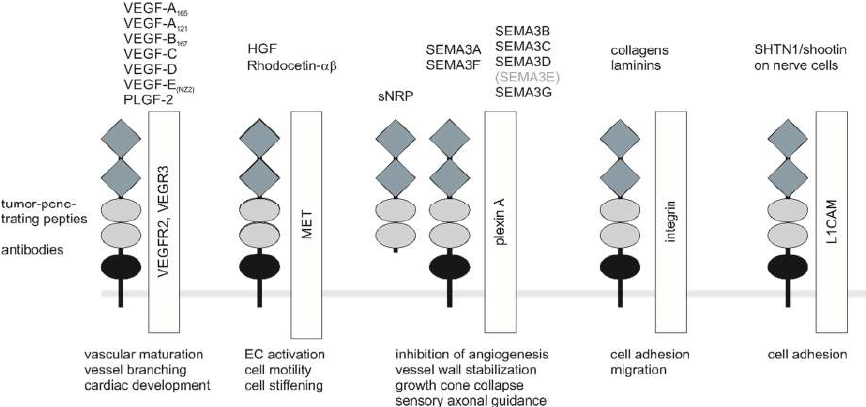
Figure 2. NRP coreceptors, ligands, and NRP-targeting compounds. For clarity, only monomers of receptors and coreceptors are shown. For signaling, dimerized ligands bind to a NRP dimer that interacts with a pair of receptor type kinases or plexin receptors. Soluble sNRP isoforms can interfere with the signaling of NRP-containing holoreceptors. Physiological NRP ligands involved in angiogenesis and tumor angiogenesis, vascular branching and maturation, as well as cardiovascular development, are VEGF-A 165 , VEGF-B 167 , VEGF-C, VEGF-D, VEGF-E, and PLGF-2. Among the semaphorins important for the nervous system, the secreted forms SEMA3A and SEMA3F as well as the membrane proteins, SEMA3C and SEMA3D, have important functions in the tumor vasculature. SEMA3E is the only semaphorin that directly binds to a plexinD1 to control vascular patterning independent of NRP [98]. Nevertheless, the extracellular domain of NRP1 can modulate SEMA3E-triggered plexinD1 signaling [99]. In addition to lateral interactions, transcellular interactions are also possible for NRP. Tumor-penetrating peptides interact with the arginine-binding pocket within the b1 domain of NRP. The snake-venom-derived rhodocetin- αβ also interacts with the b1 domain and recruits NRP1 to the hepatocyte growth factor (HGF) receptor, MET. a1/2 domain, grey diamonds; b1/2 domain, light grey ellipses; c domain, black